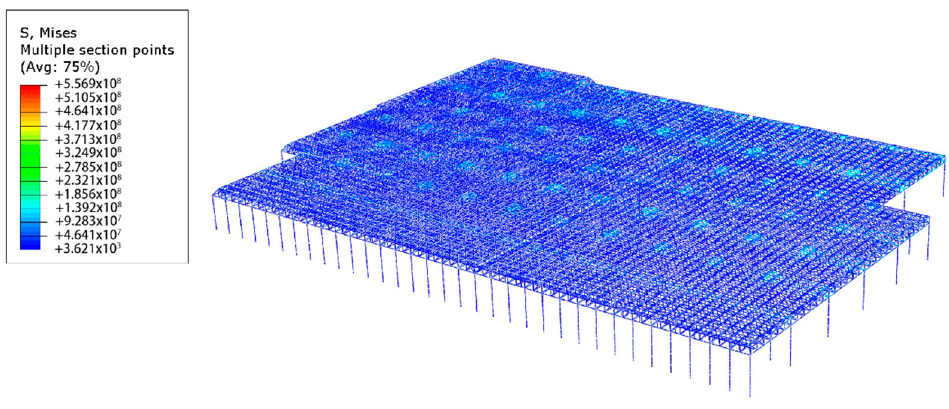
Figure 12. Equivalent von Mises stress distribution of the steel-reinforced concrete columns.